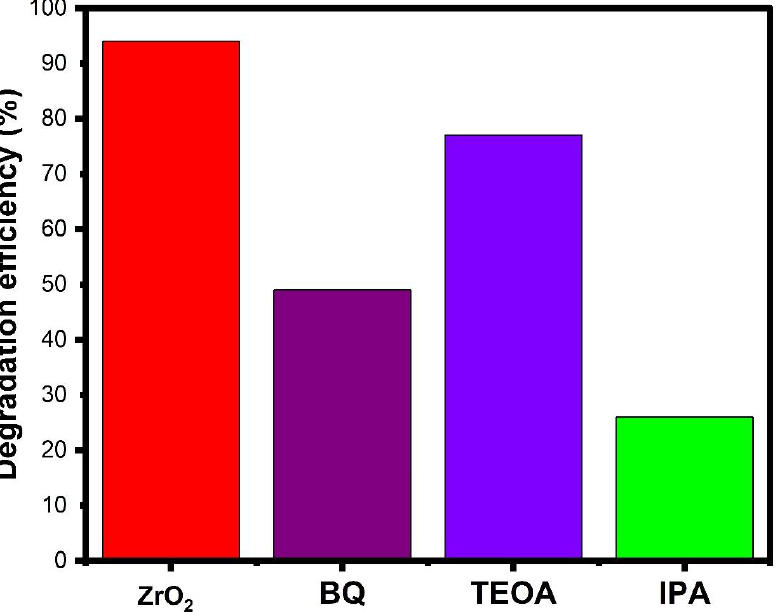
Figure 8. Quenching experiment.